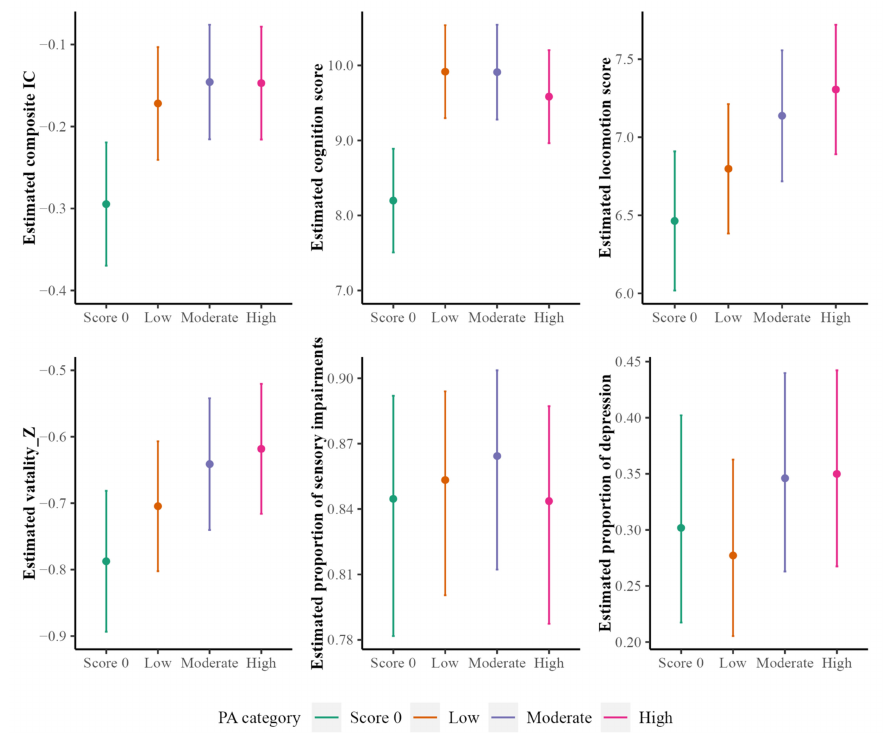
Figure 3. Estimated general IC scores (and scores/proportion for each of the five IC domains) with 95% confidence intervals (CIs) versus TPA levels. The estimation is based on a linear mixed-effects model for continuous outcomes and a generalized linear mixed-effects model for binary outcomes.